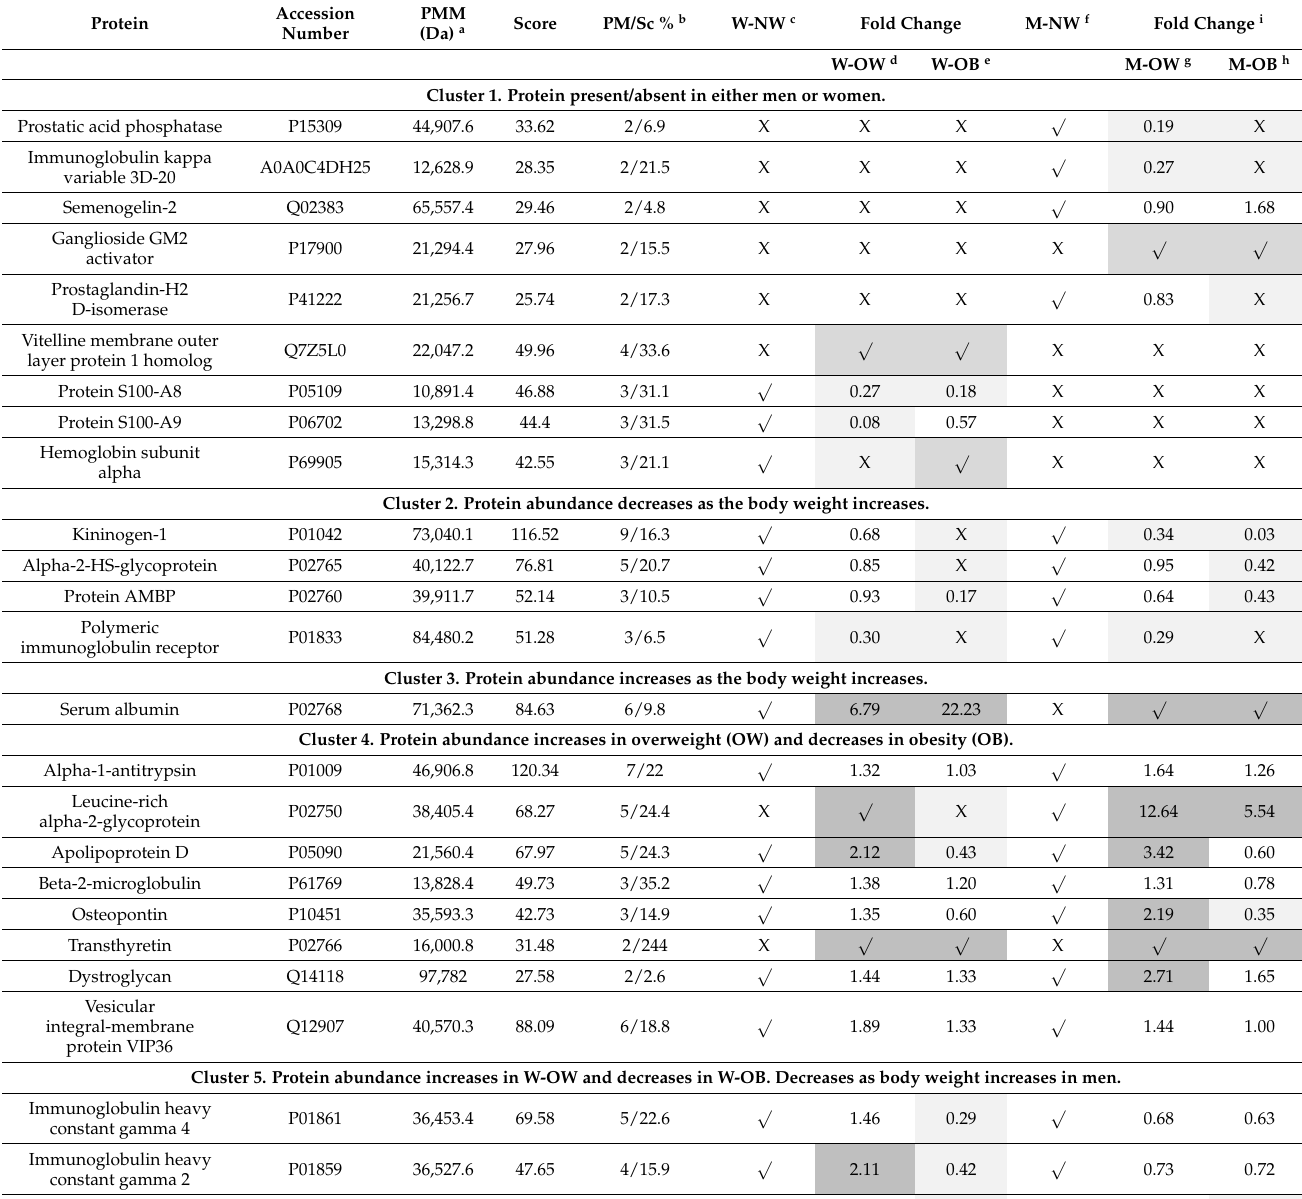
Table 1. Identification of proteins with different abundance patterns in urine pooled samples from groups of men and women with normal weight (control), overweight and obesity.